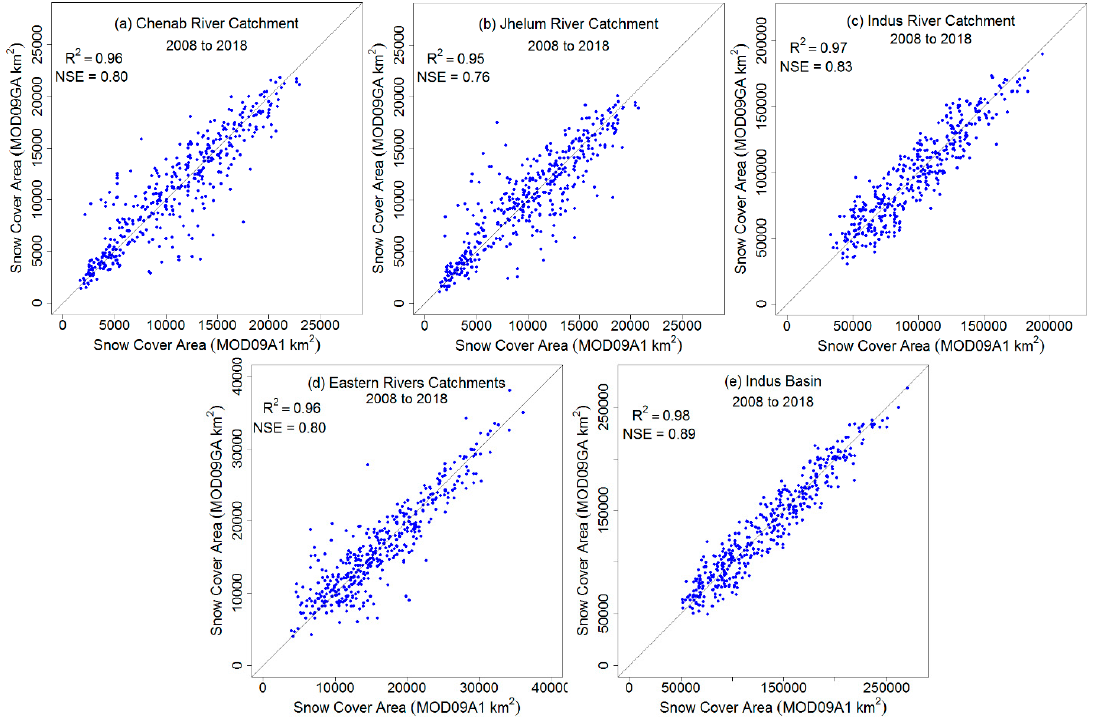
Figure 9. ( a – e ). Intercomparison of MOD09GA and MOD09A1 time series snow cover area from 2008 to 2018 for Indus basin and its sub-catchments.